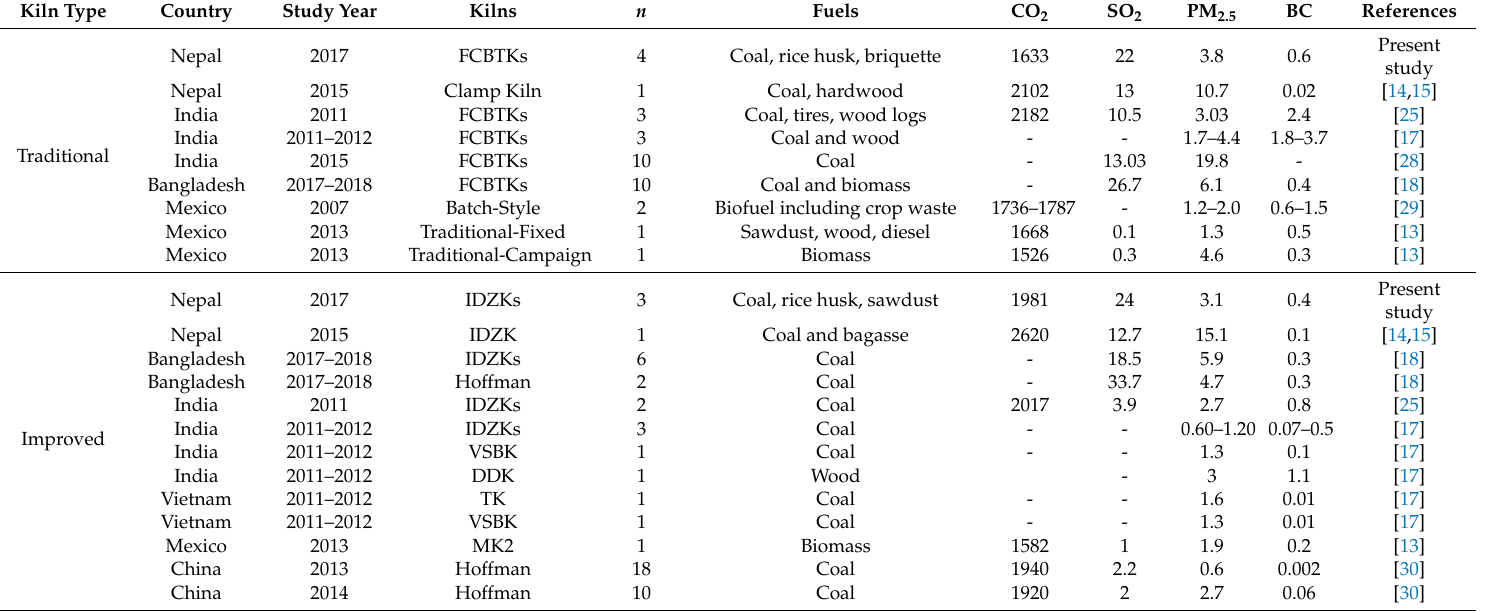
Table 5. Summary of fuel-based emission factors (g/kg of fuel) of different pollutants in this study compared to previous